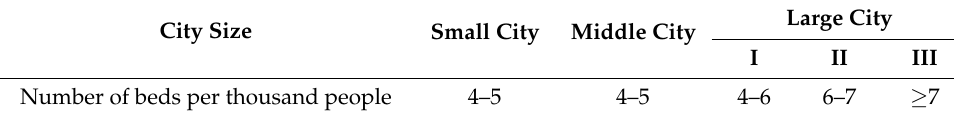
Table 3. The standard of the number of beds per thousand